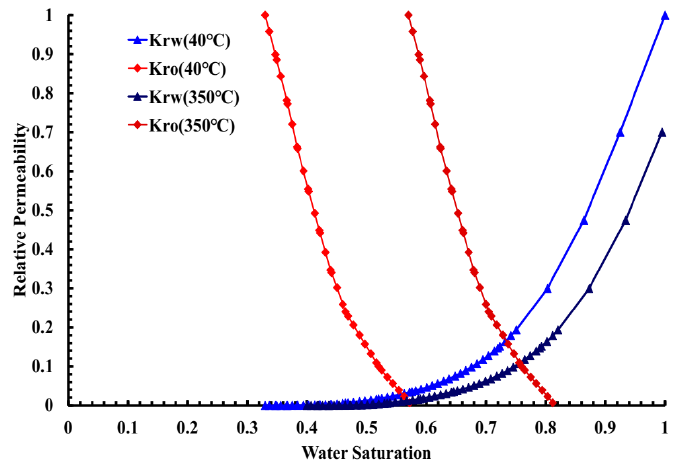
Figure 2. Oil-water relative permeability at different temperatures.